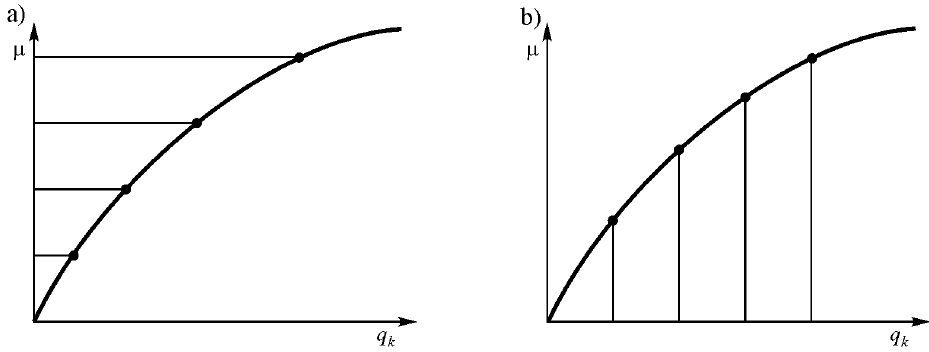
Figure 2. Control of an incremental process: ( a ) by load, ( b ) by displacement.